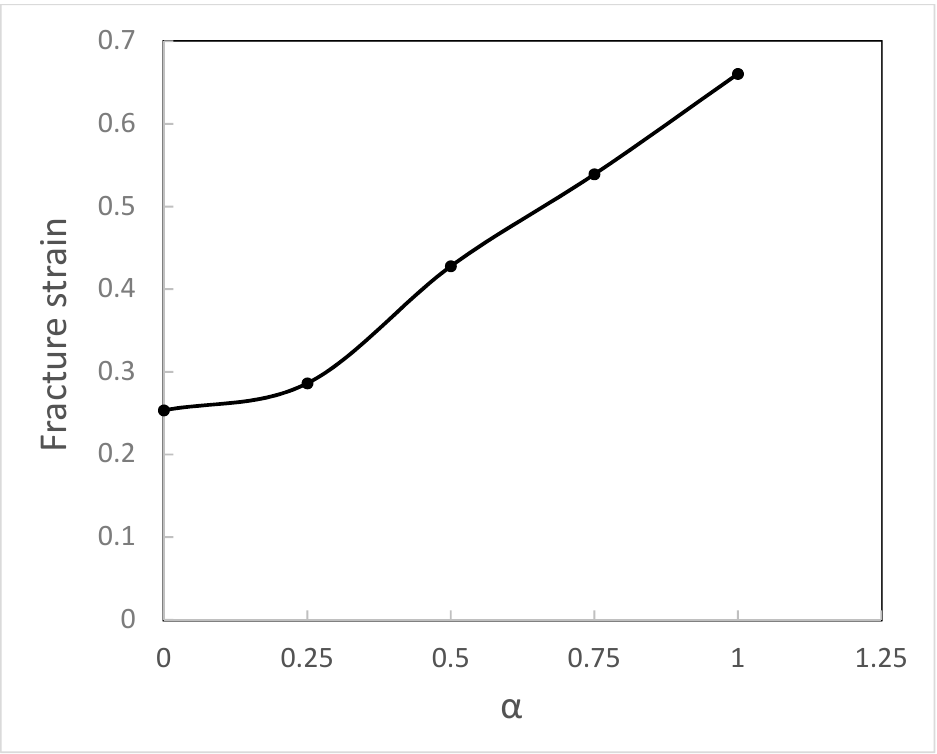
Figure 12. Effect of pressure on fracture strain.